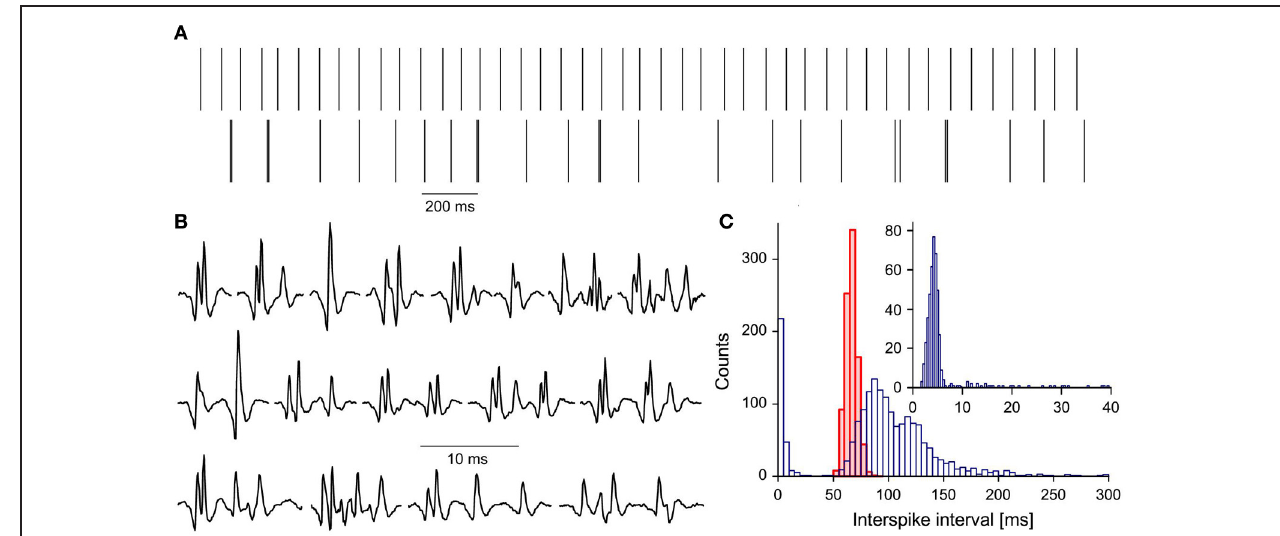
FIGURE 1 | Characteristics of E-MU: (A) discharge patterns: upper trace, N-MU; lower trace, E-MU. Each discharge represented by a vertical line; (B) a variety of E-MU potential shapes; (C) histograms of interspike intervals: